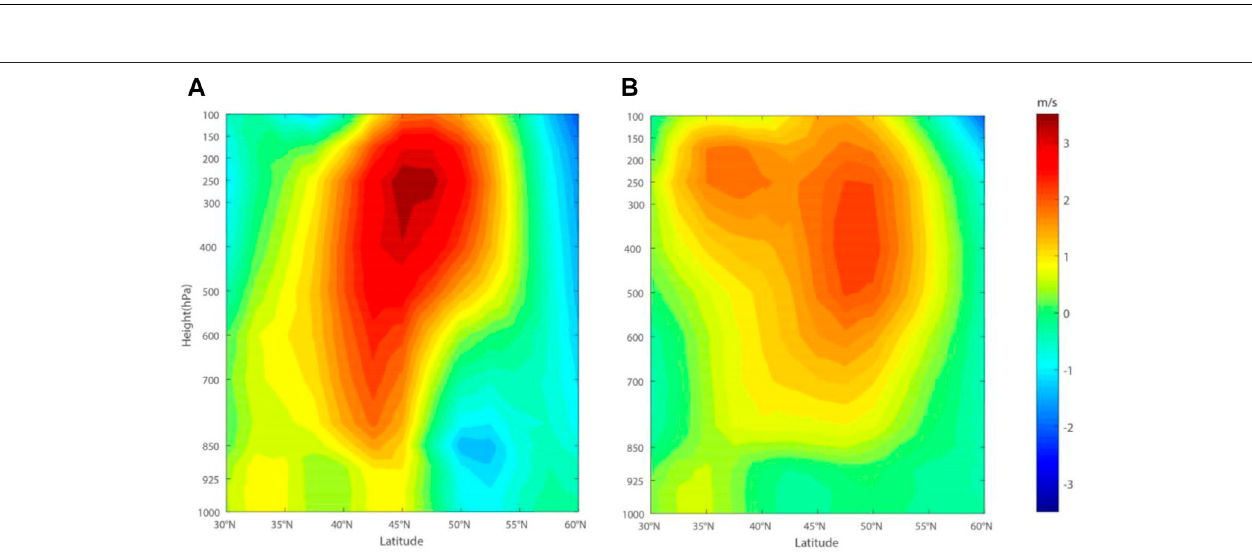
FIGURE 12 | Cross-section of difference of average zonal wind speed (70 – 100E ° ) between (A) rising period 1960 – 1979, (B) 2000 – 2015 and declining period (1990 – 1999).